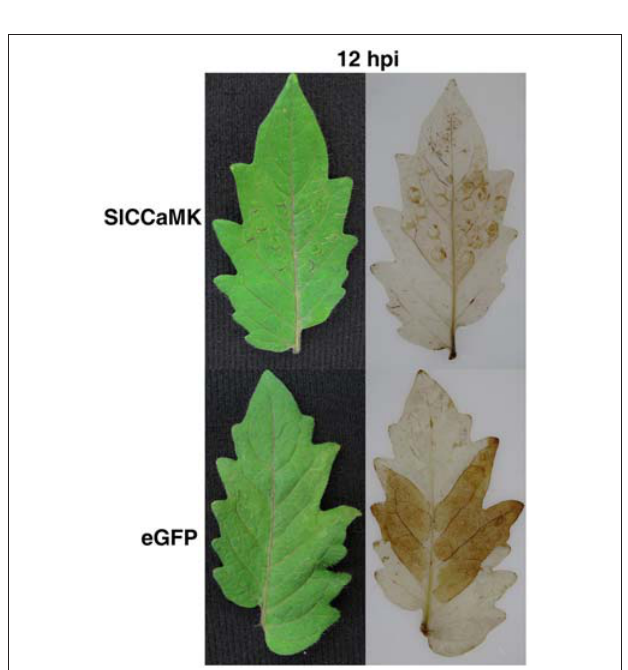
FIGURE 8 | Knock-down of the SlCCaMK gene by VIGS reduced H 2 O 2 accumulation. Tomato leaves of the SlCCaMK -silenced and the eGFP control plants were collected at 12h post infiltration with Pst DC3000 or with sterilized water as a control, and stained with DAB. Leaves both before (Left panels) and after (Right panels) staining were